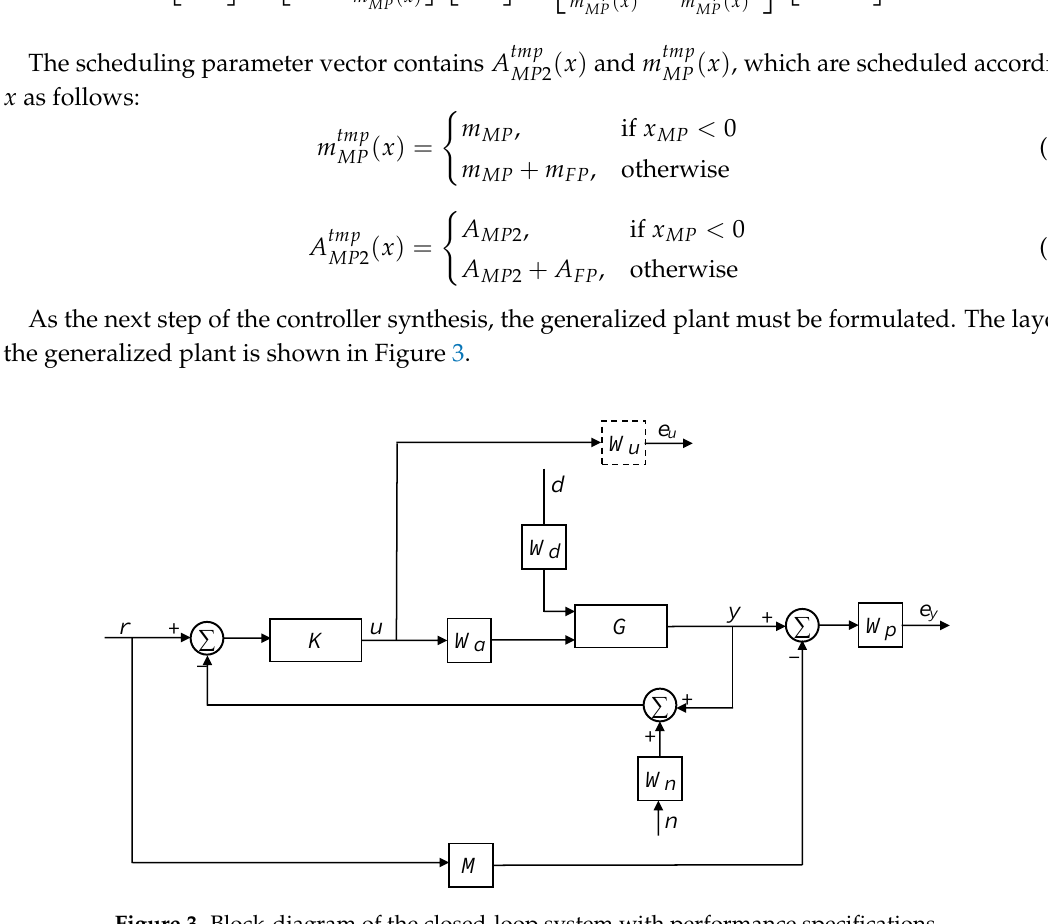
Figure 3. Block-diagram of the closed-loop system with performance